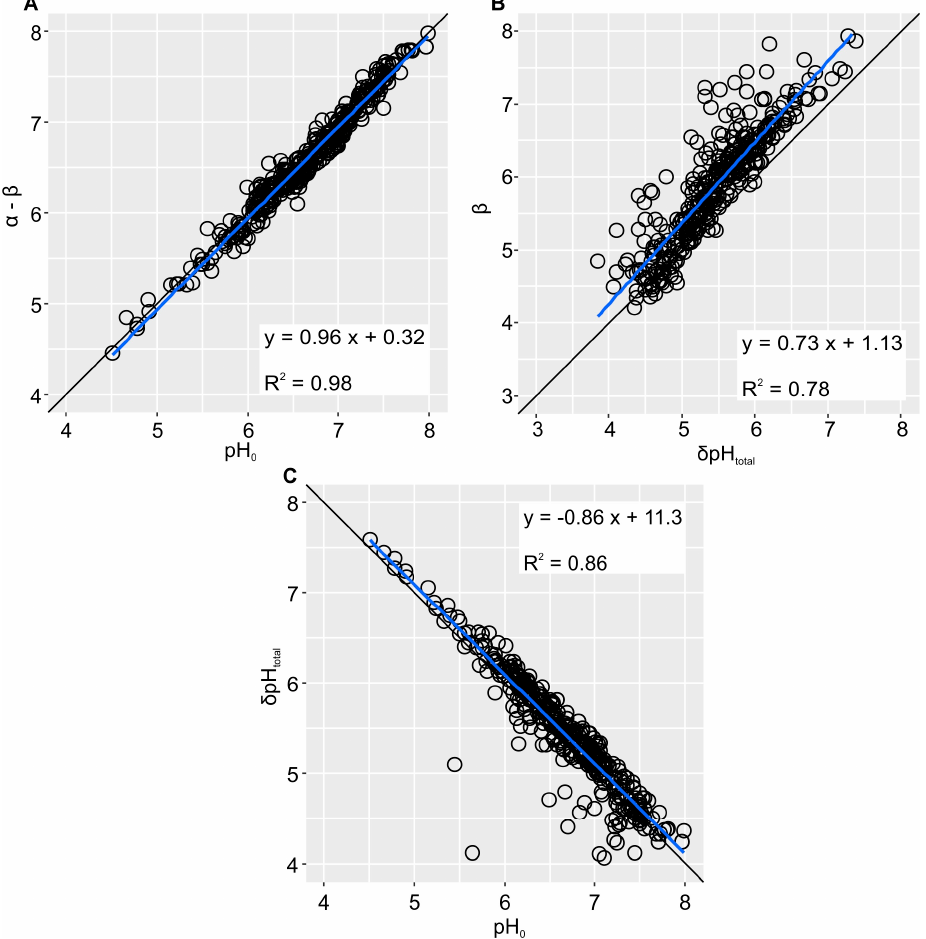
Figure 3. Correlations between ( A ) the BNC regression coefficients α − β and pH 0 , ( B ) β and the total